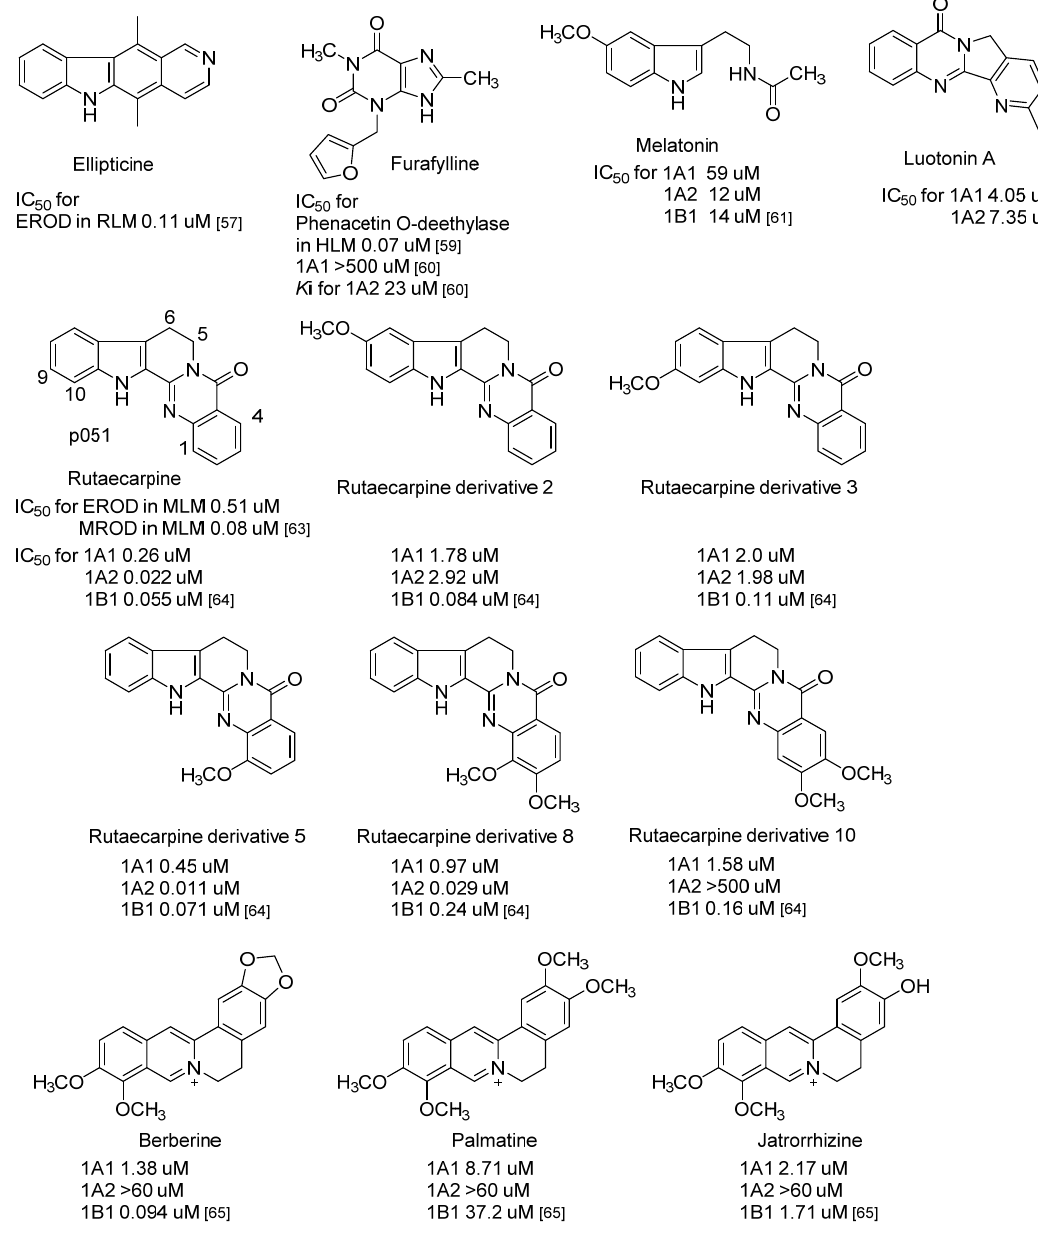
Figure 6. Structures of alkaloids as P450 family 1 inhibitors (RLM, rat liver microsome; HLM, human liver microsome; MLM, mouse liver